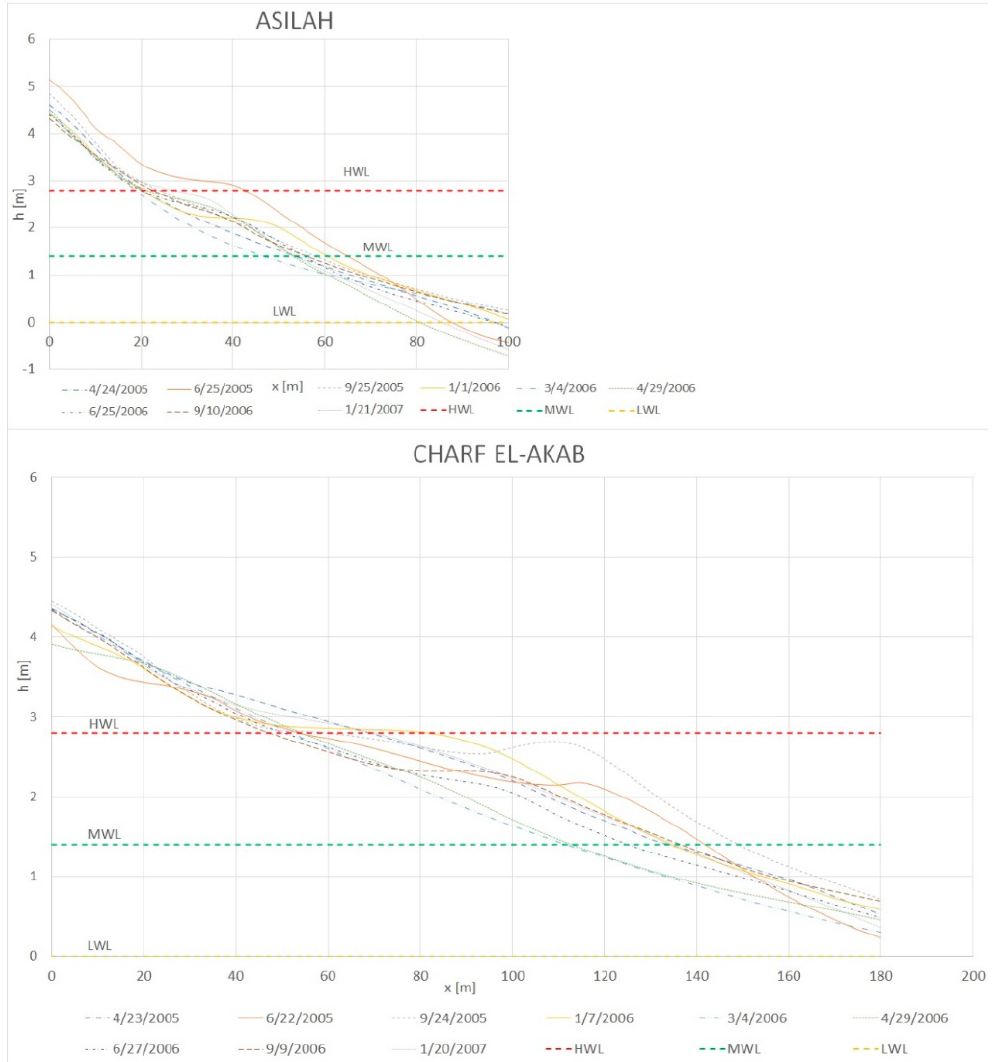
Figure 3. Topographic profiles. These are the mean profile of each beach over time from data collected in the field. The profiles are used to perform the statistical calculations and the complementary empirical orthogonal function (EOF) analyses. Profile dates are reported in the legend. High, mean, and low water levels are represented as HWL, MWL, and LWL, respectively. Levellings of the mean profile (h) are presented on the vertical axis.